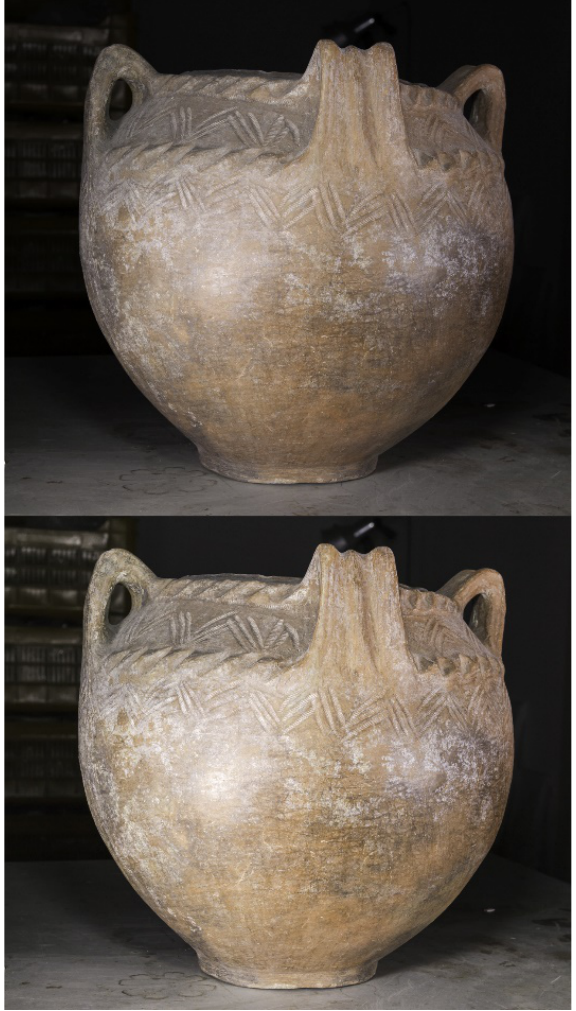
Fig. 7 Raw development example: top image open in Lightroom, bottom image exported by